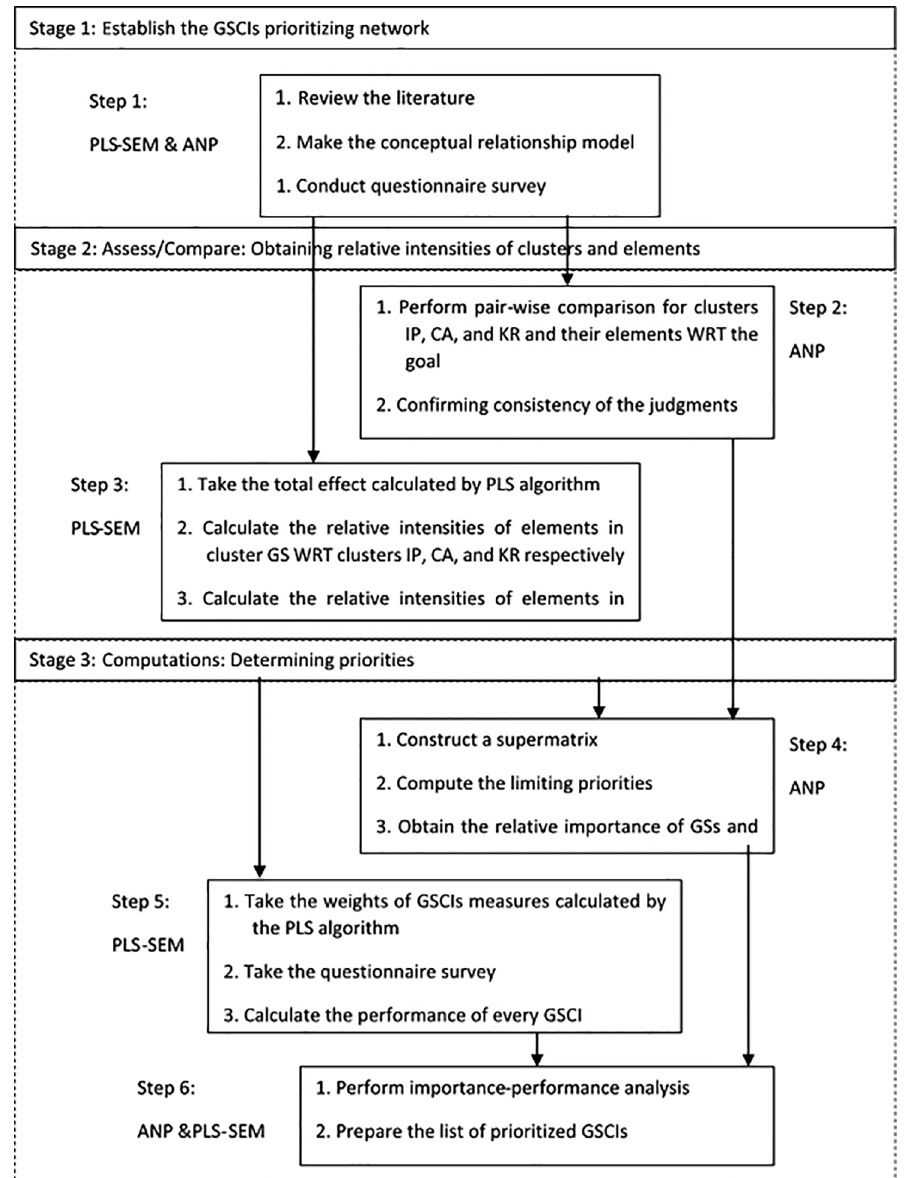
Fig 1. The proposed research